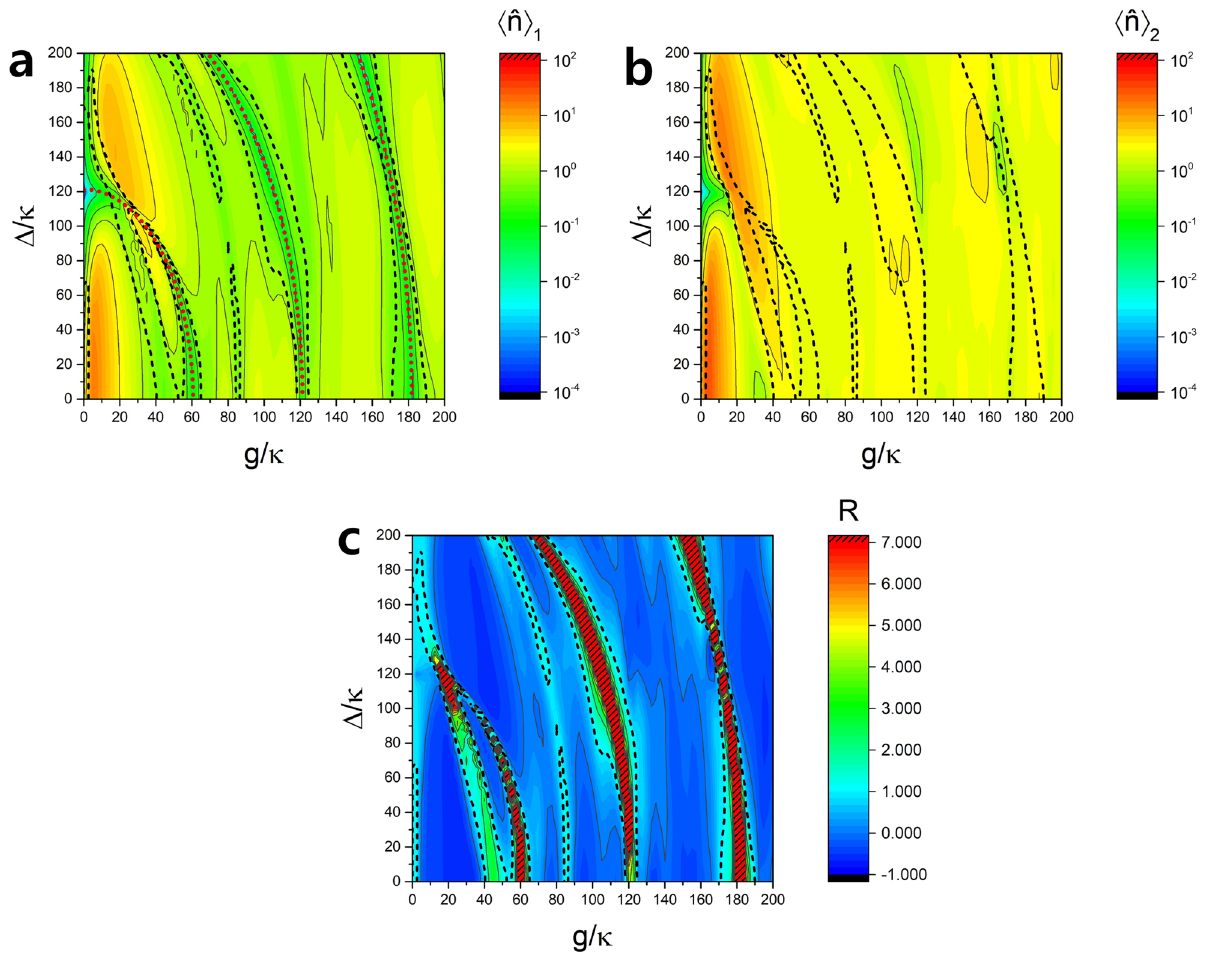
Figure 2. Dependance of hyperradiance on g/ κ and �/κ . ( a ) Average number of photons in the cavity of one- atom case. Red dotted curves are the ellipsoidal curves given by Eq. (10). ( b ) The same for two-atom case. ( c ) Radiance witness R . The hatched red region indicates R > 7.0 . The Rabi frequency is �/κ 0.052 /κ , the cavity decay time 1 /κ time τ = dashed